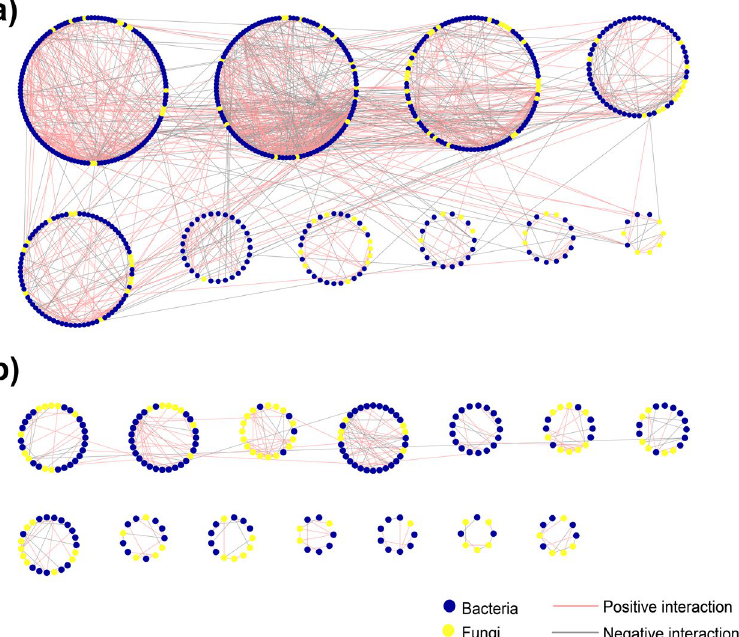
Figure 3. Network interaction graphs for the deciduous forest site M (545–570 m asl) ( a ) and the coniferous forest site R (1,724–1,737 m) ( b ) based on random matrix theory analyses from OTU-based bacterial and fungal community structures. Each node represents a bacterial (blue) or fungal (yellow) OTU. A line connecting two nodes prepresents the positive (red) or negative (gray) interaction between them. OTUs were separated into different modules, shown as circles, by the greedy modularity optimization method. Only modules ≥ 10 nodes have been represented.